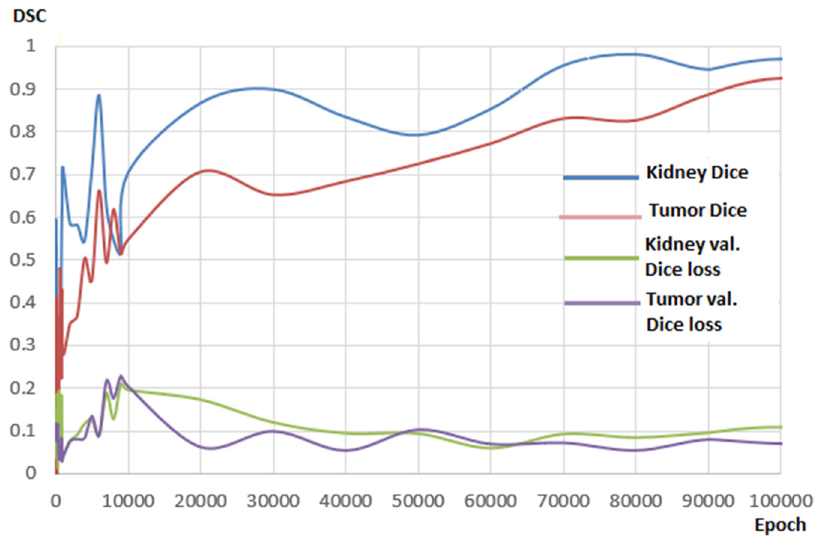
Figure 11. Kidney and tumor Dice and validation Dice loss.